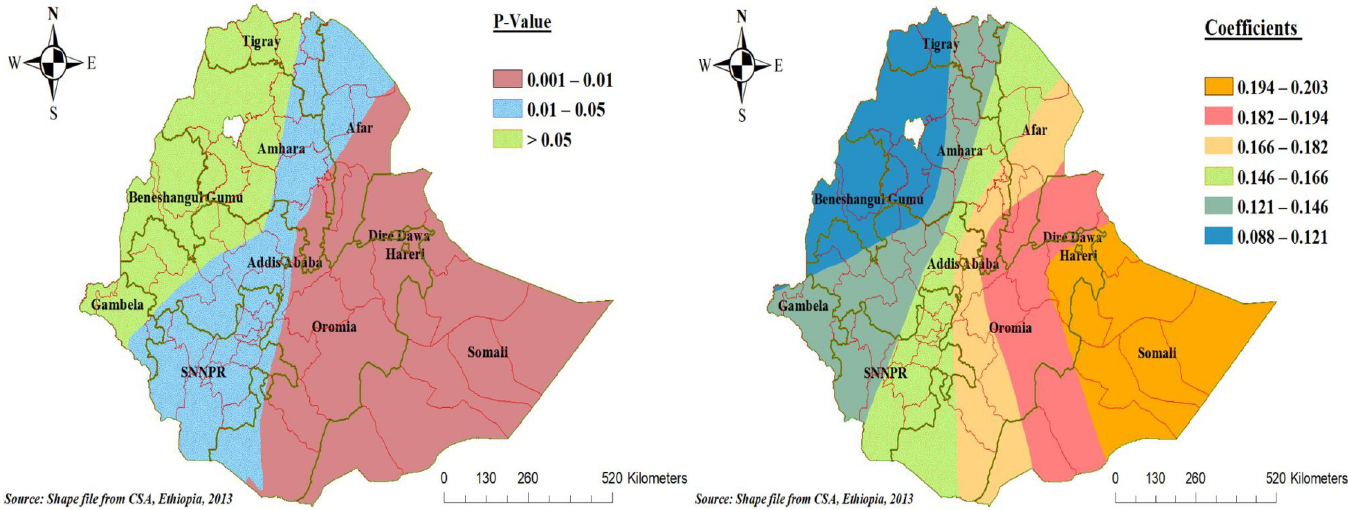
Fig 5. Geographically varying values of significance level and coefficients per cluster for independent variable poor wealth household status of poor consumption food rich in vitamin A in the final GWR model.